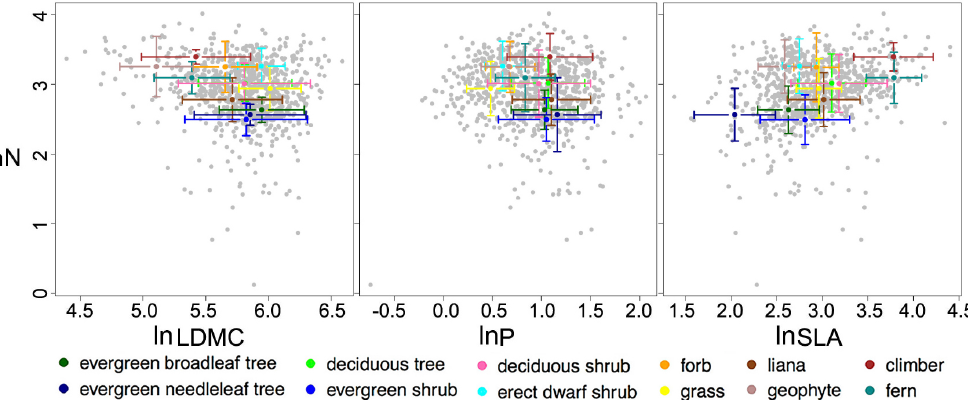
Figure 5. Illustrative plots showing means and standard deviations of trait values within PFTs for ln N area combined with lnLDMC, ln Parea and